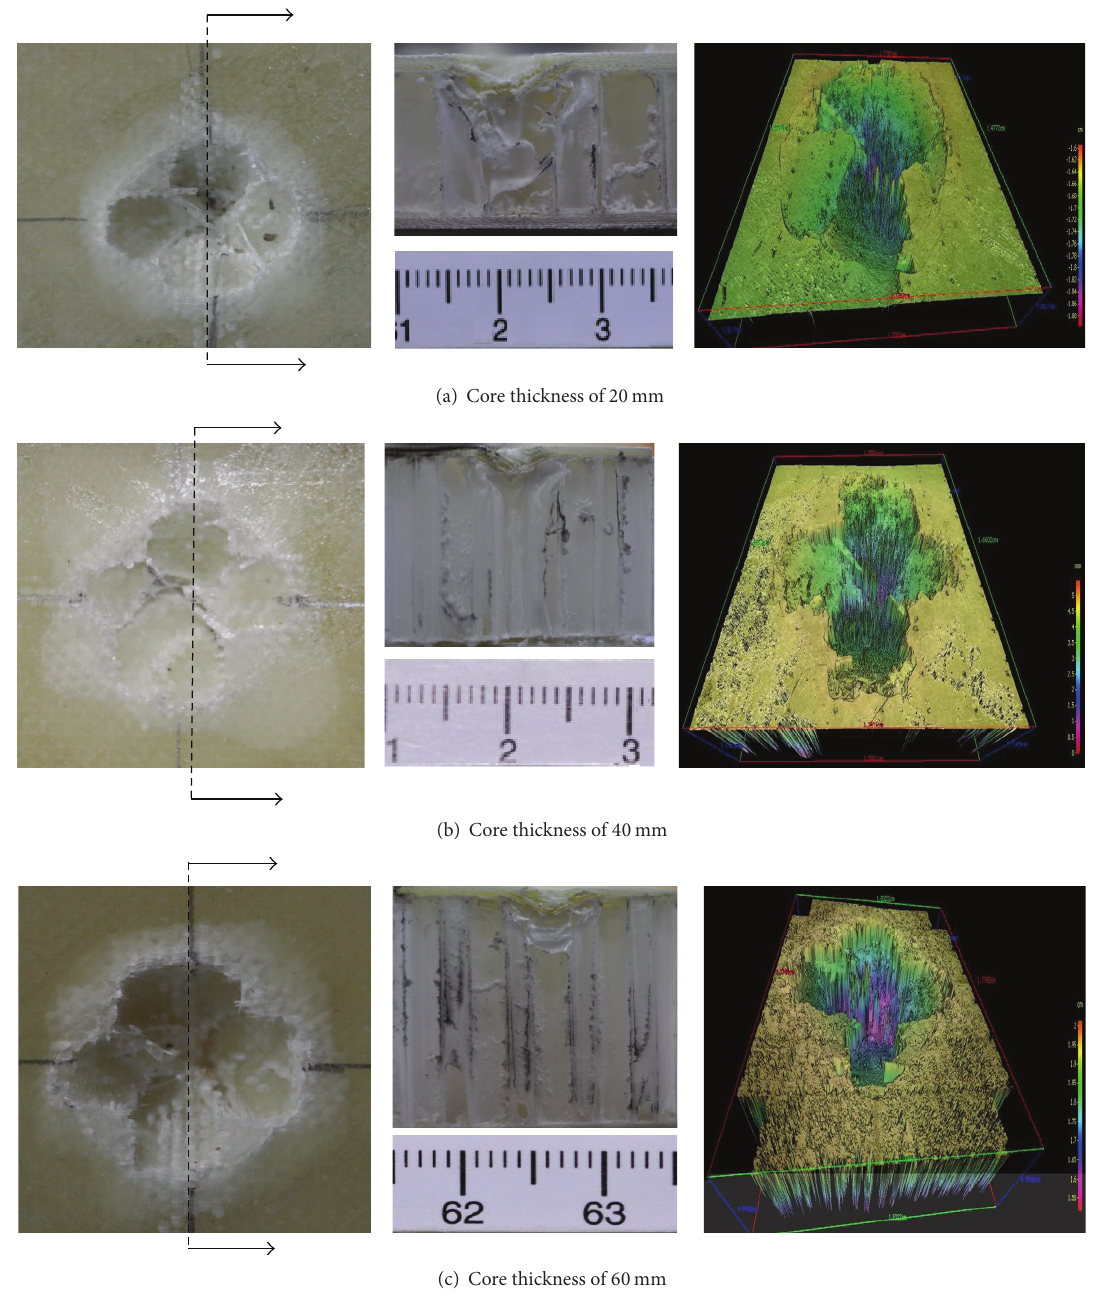
Figure 12: Impacted surfaces, cross-sectional views, and optical surface metrology of the sandwiches subjected to 30 J of